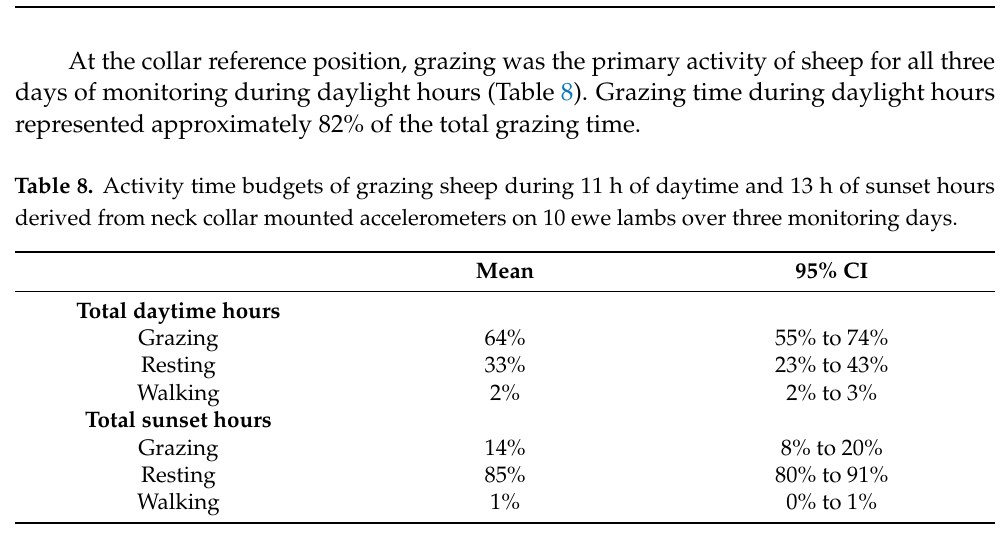
Table 7. The mean (95% confidence limits, CL) daily time spent grazing, resting, and walking for three days recorded continuously by tri-axial accelerometers positioned on a neck collar, head halter and body harness of ewe lambs ( n = 10).